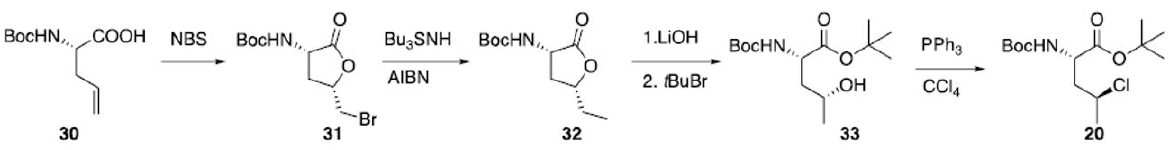
Scheme 1. Synthesis of γ -chloronorvaline ( 20